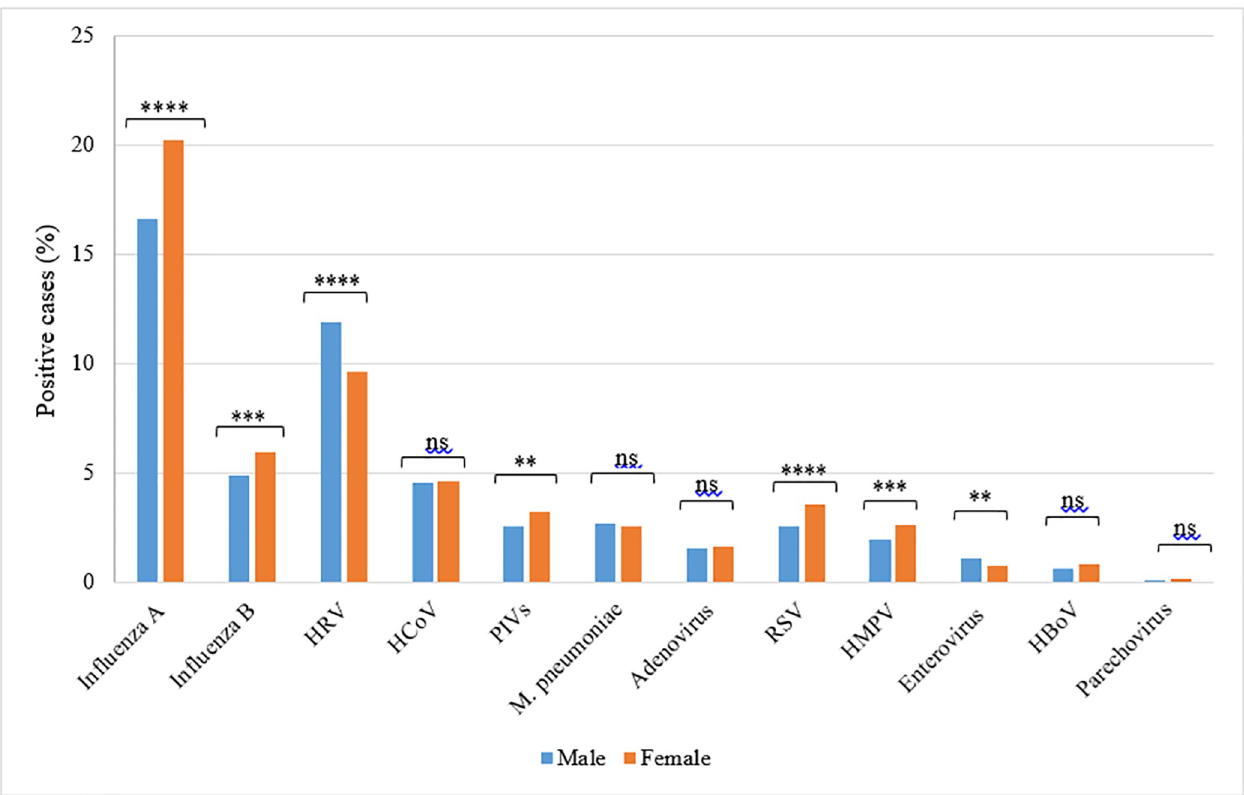
Fig 5. Rate of ILI infections among males and females. The difference in the infection rate between the two groups was calculated using Pearson Chi2 and the Fisher Exact test. P-value less than 0.05 is flagged with one star ( � ). P-value less than 0.01 is flagged with two stars ( �� ). P-value less than 0.001 is flagged with three stars ( ��� ). P-value less than 0.0001 is flagged with four stars ( ���� ). Ns: not significant.